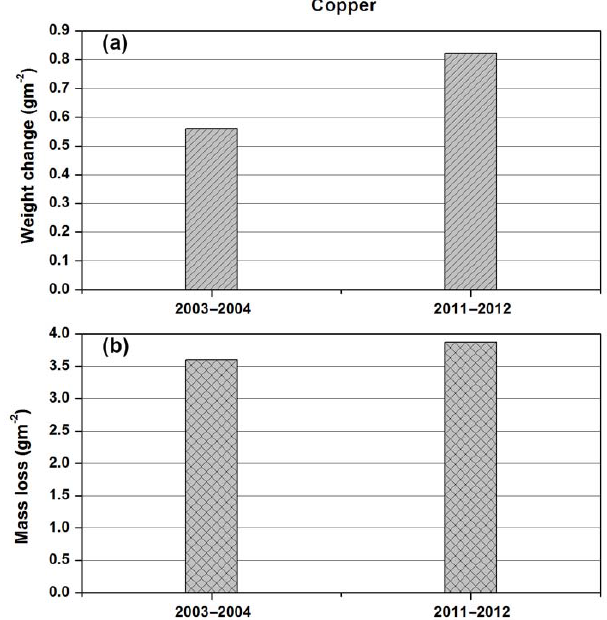
Figure 2. (a) Mean weight change and (b) mean mass loss of copper samples exposed during the periods 2003–2004 and